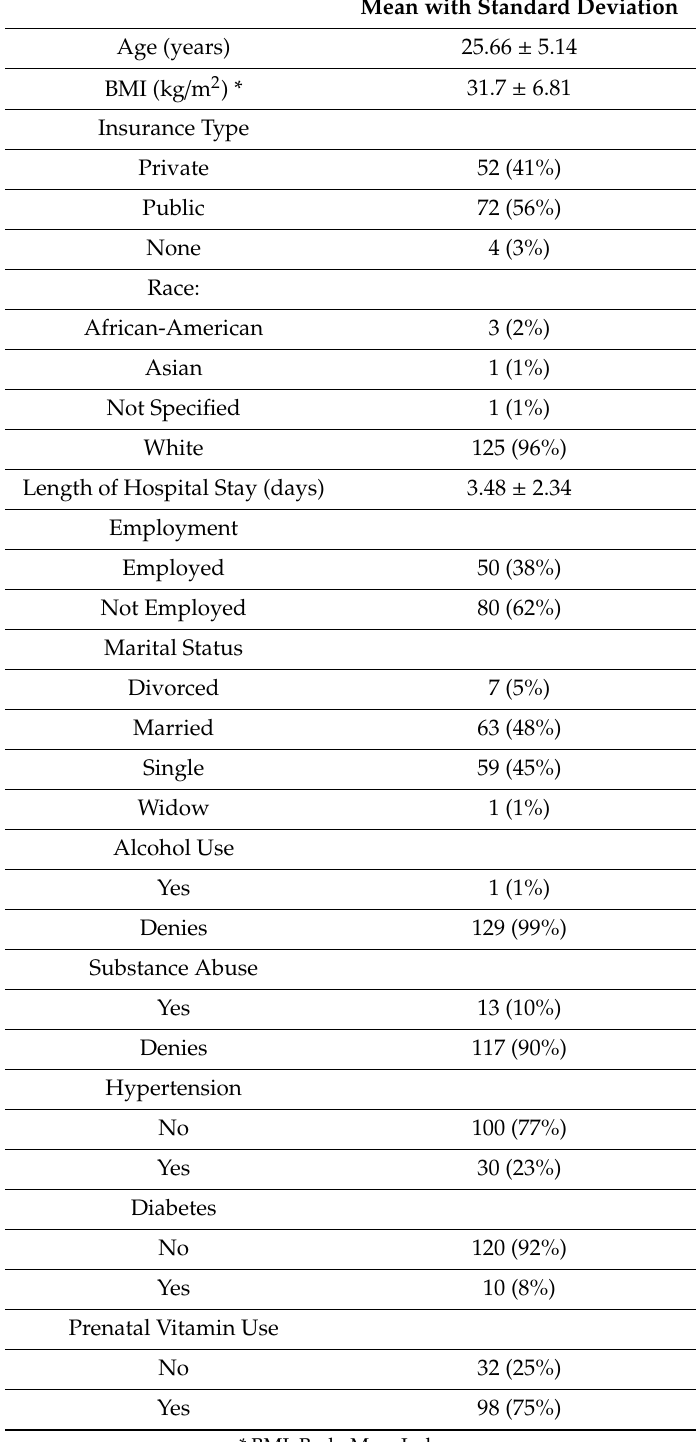
Table 2. Maternal Information. Reported mean ± standard deviation (SD) for continuous variables or n (%) for categorical variables. 95% confidence